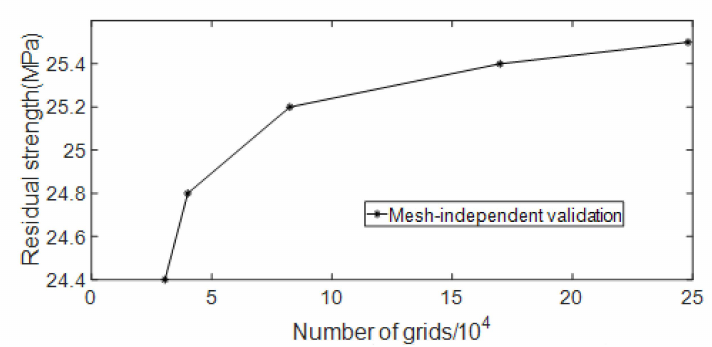
Figure 12. Mesh-independent validation of strength model.